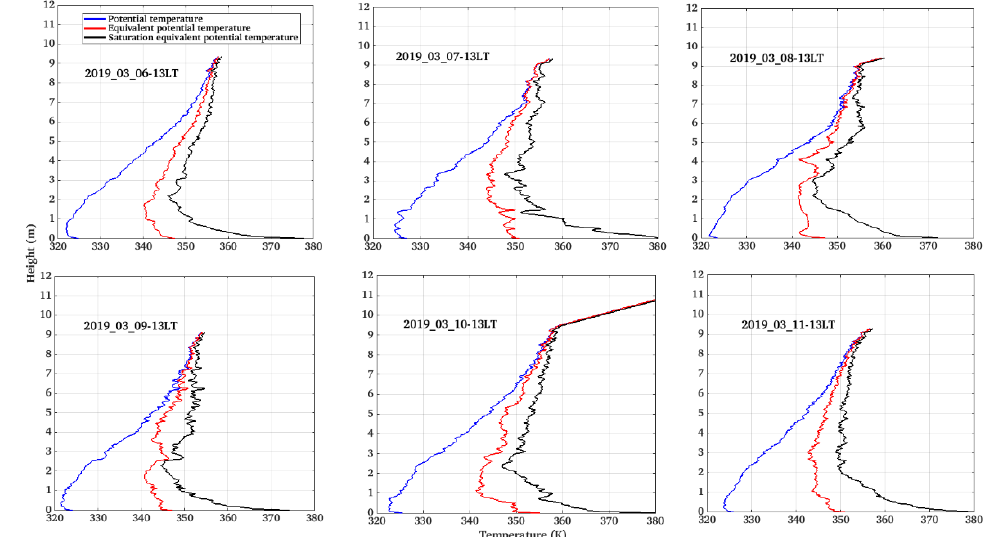
Figure 13. Equivalent potential temperature, saturation equivalent potential temperature and potential temperature calculated from the radiosonde data for 06–11 March at 13 LT.